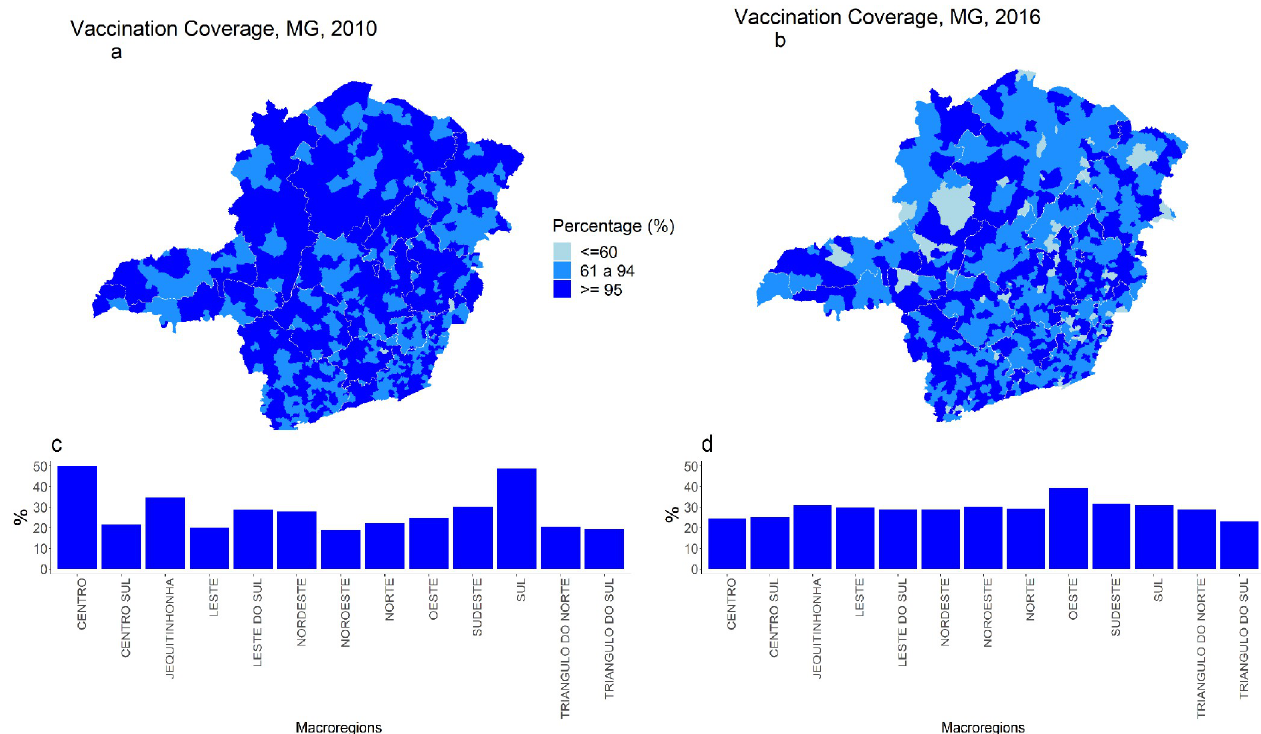
Fig 3. Yellow fever vaccination coverage in children under one year of age according to macroregions, Minas Gerais, Brazil, 2010 and 2016. Vaccination coverage was consulted on the website of the Brazilian Ministry of Health (DATASUS). The data refer to vaccination coverage in children under one year of age and classified in three categories, less than 60%, 61% to 94%, and 95% or greater. Fig ( a) vaccination coverage in children under one year of age in 2010; (b) vaccination coverage in children under one year of age in 2016; (c) coefficient of variation in vaccination coverage in 2010; (d) coefficient of variation in vaccination coverage in 2016. Map created with ggplot2 and sf packages (R platform)—base layer from Instituto Brasileiro de Geografia e Estatı´stica (https:// portaldemapas.ibge.gov.br/portal.php#homepage).